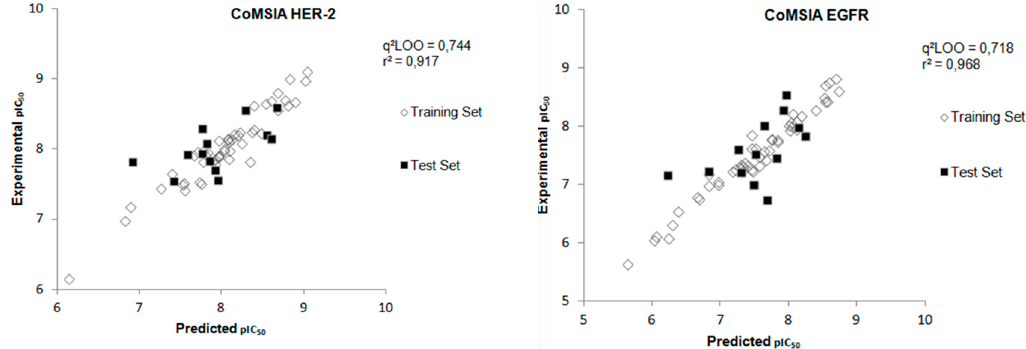
Figure 6. Experimental versus predicted pIC 50 values for the training and test sets obtained from the CoMSIA model for both biological targets. Table 4. Values of experimental and predicted pIC 50 , and the residual values, for the test set obtained from the CoMSIA model for both biological targets.